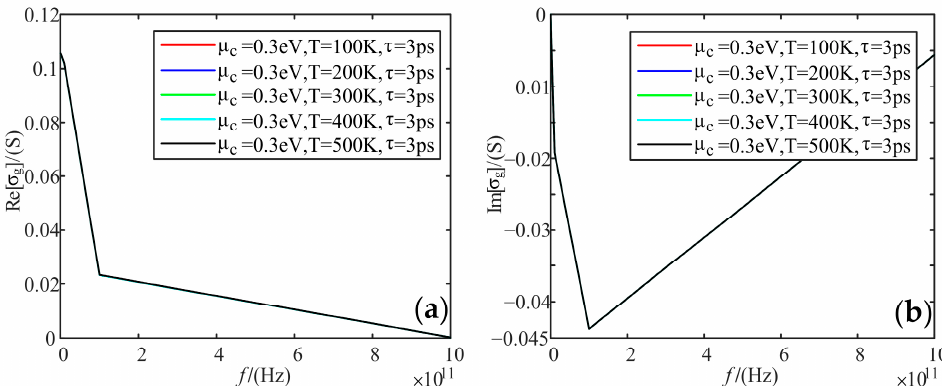
Figure 5. Variation curve of graphene total conductivity with frequency at different temperatures: ( a ) real part; ( b ) imaginary part.